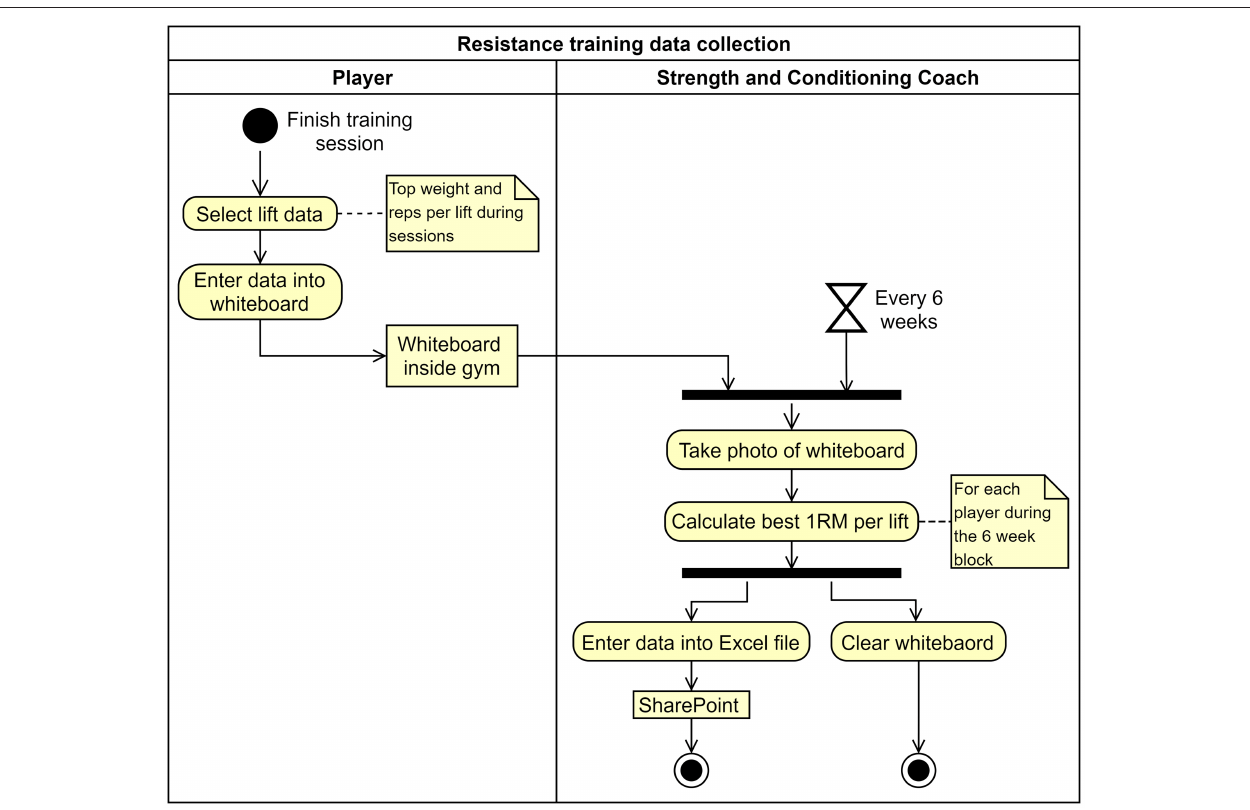
FIGURE 2 | Activity diagram of resistance training data collection prior to the optimisation (will be referred to as As-Is